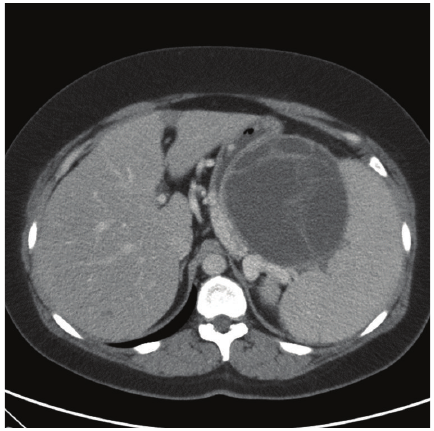
Figure 2: A computed tomography scan of the abdomen. Large cystic tumor in the tail of the pancreas along with moderate splenomegaly.